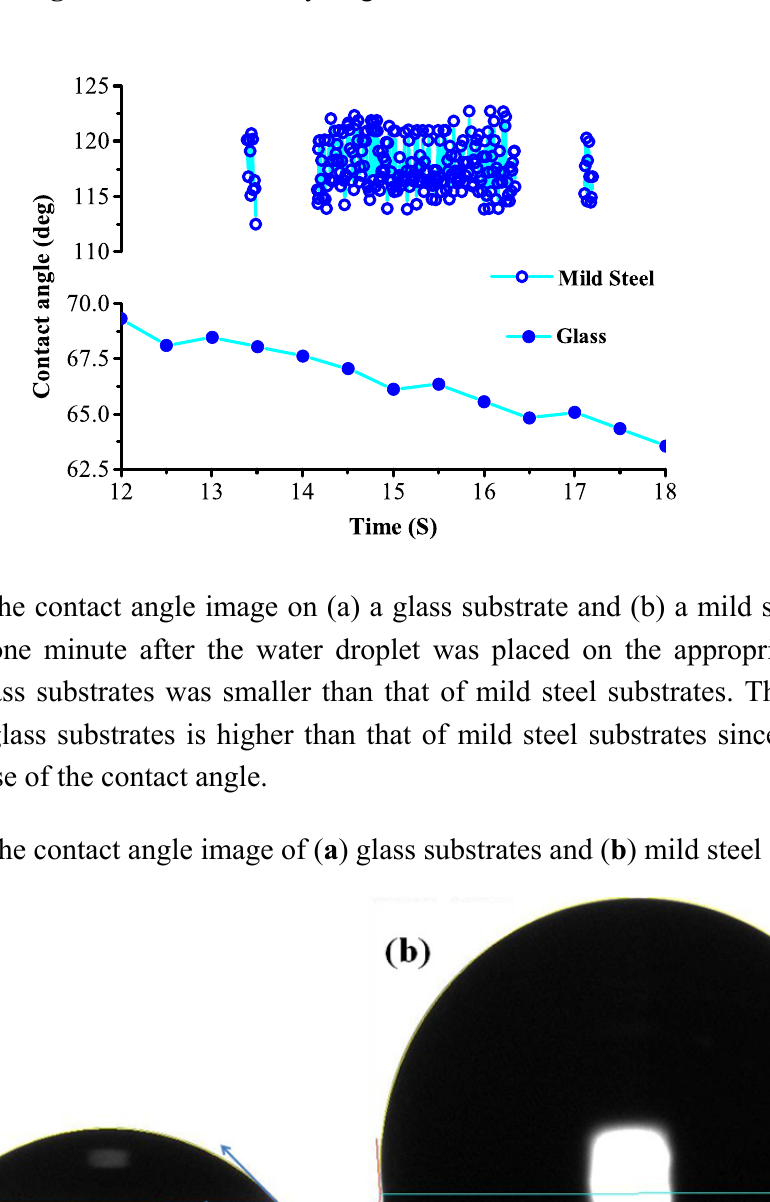
Figure 1. The wetability of glass and mild steel substrates.